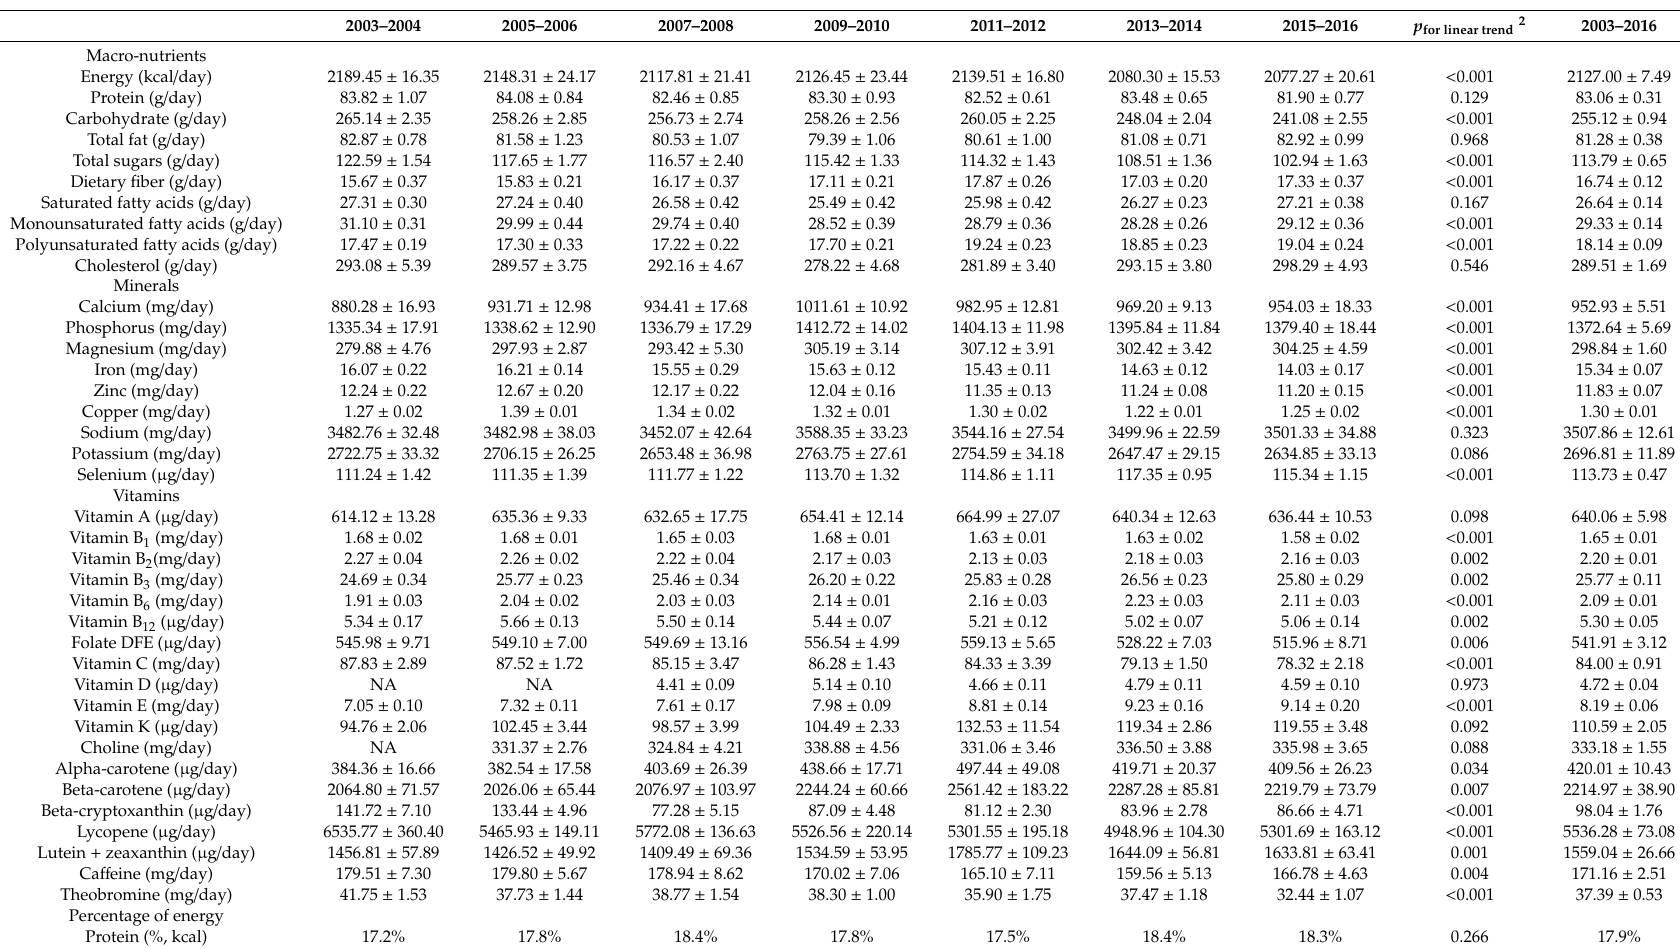
Table 2. Trends in dietary nutrient intake among US adults in the National Health and Nutrition Examination Survey (NHANES 2003–2016)